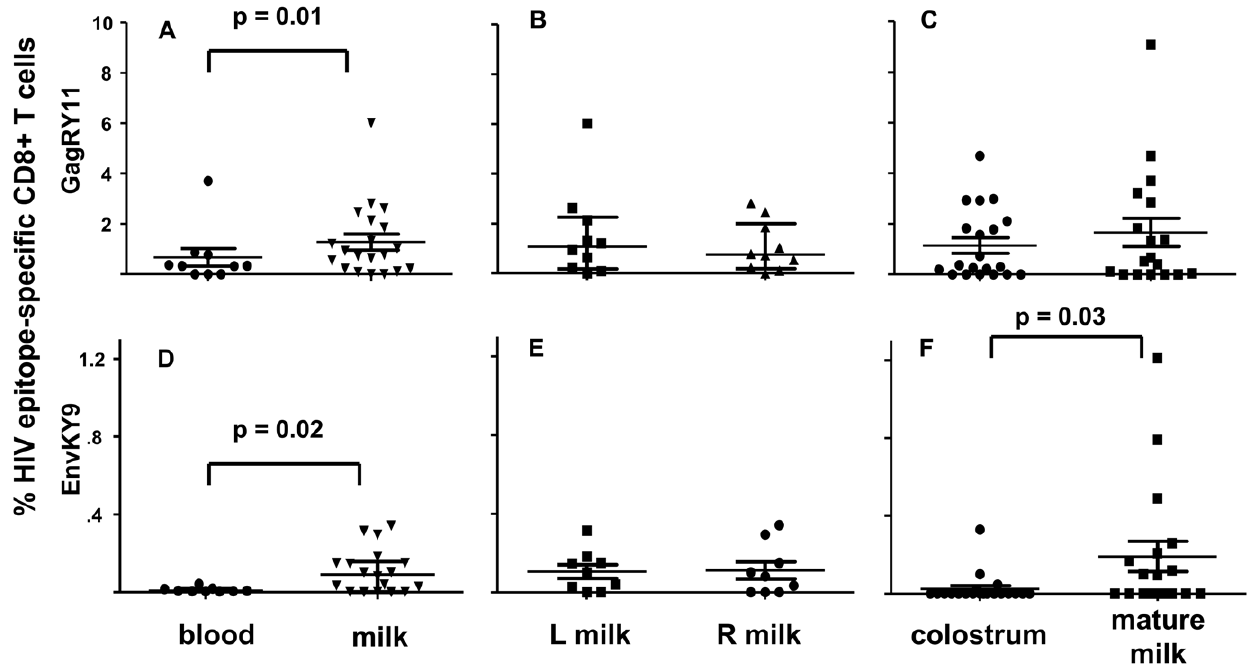
Figure 2. High magnitude HIV-specific CD8 + T lymphocyte responses in milk. The mean immunodominant GagRY11-specific (A) and subdominant EnvKY9-specific (D) CD8 + T lymphocyte response blood and milk of 10 HIV-infected, lactating women. The GagRY11-specific (B and C) and EnvKY9-specific (E and F) CD8 + T lymphocyte responses in the left and right breast and colostrum and mature milk. Line indicates the median of the responses among all subjects, p values # 0.05 are indicated.